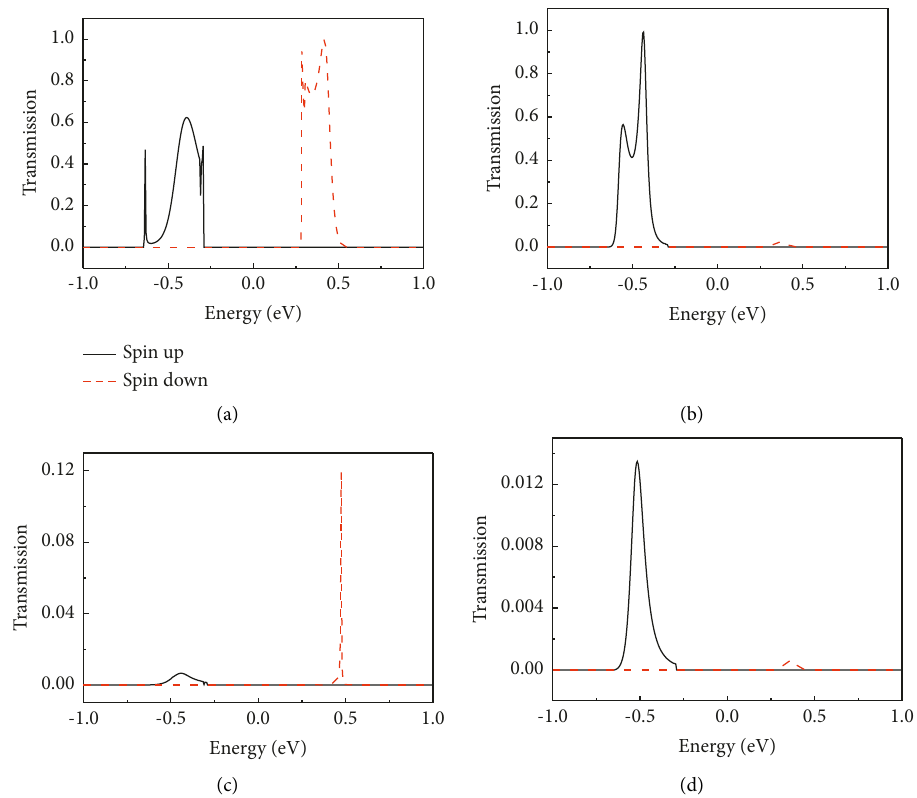
Figure 2: The spin-dependent TS of the thermal spin device, (a) R state, and (d) R CH 2 , open state. The red and black lines indicate the SU and SD electrons, (cid:31)